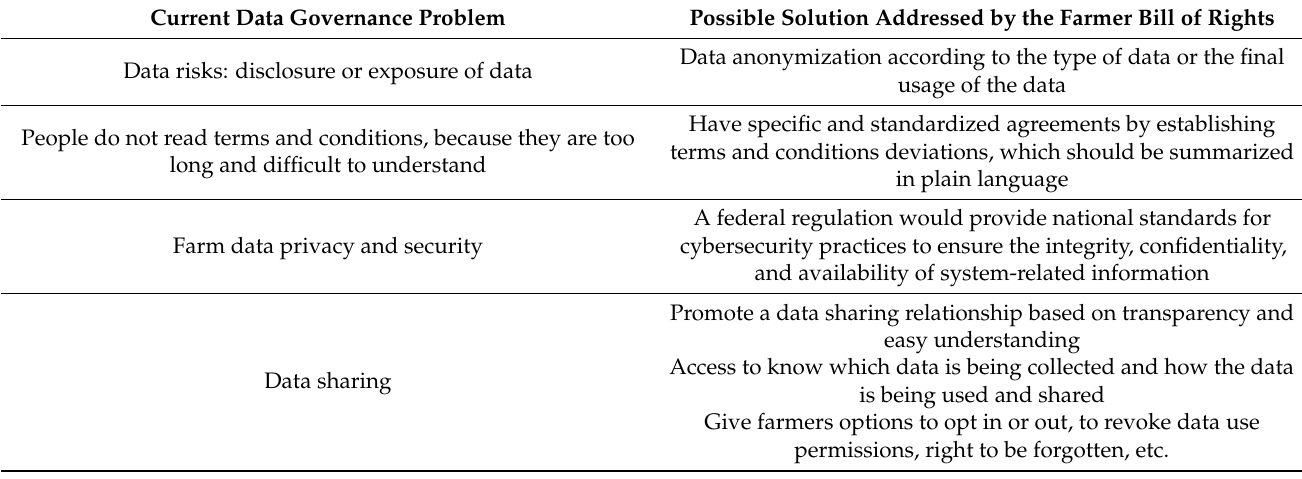
Table 1. Data governance issues and their possible solutions addressed by the proposed Farmers Bill of Rights. Current Data Governance